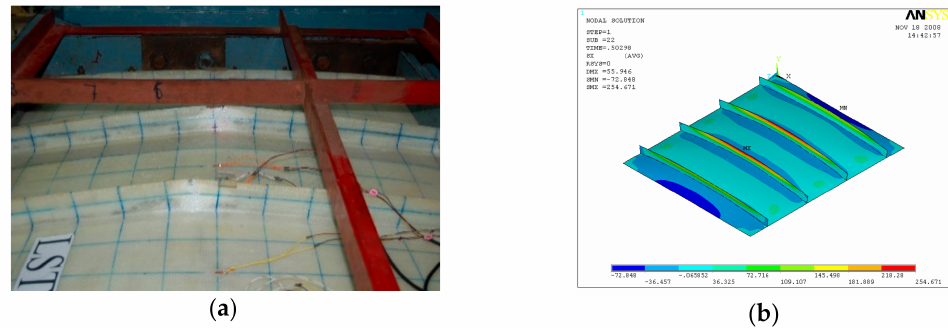
Figure 15. Failure of LSTP4. ( a ) Experiment ( b )